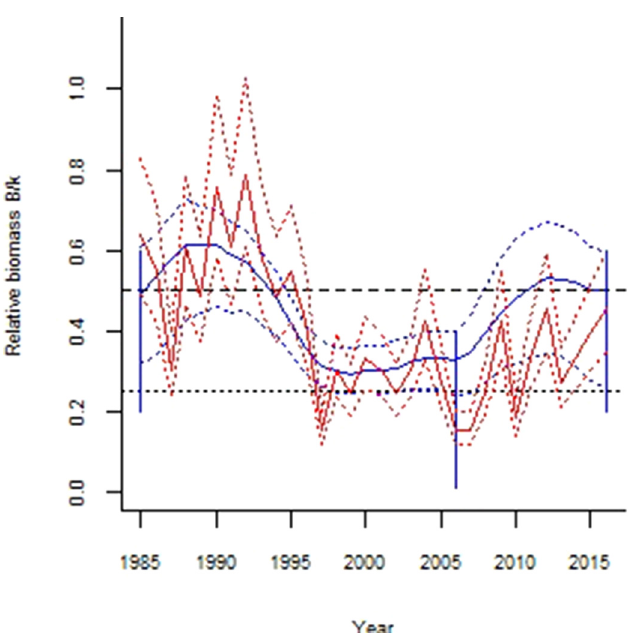
Fig. 9. Schaefer equilibrium curve of S. undosquamis catch/MSY relative to B/ k . Points not falling on the equilibrium curve indicates over fi shing and shrinking of biomass, if above the curve, and sustainable exploitation and growing of stock, if below the curve.